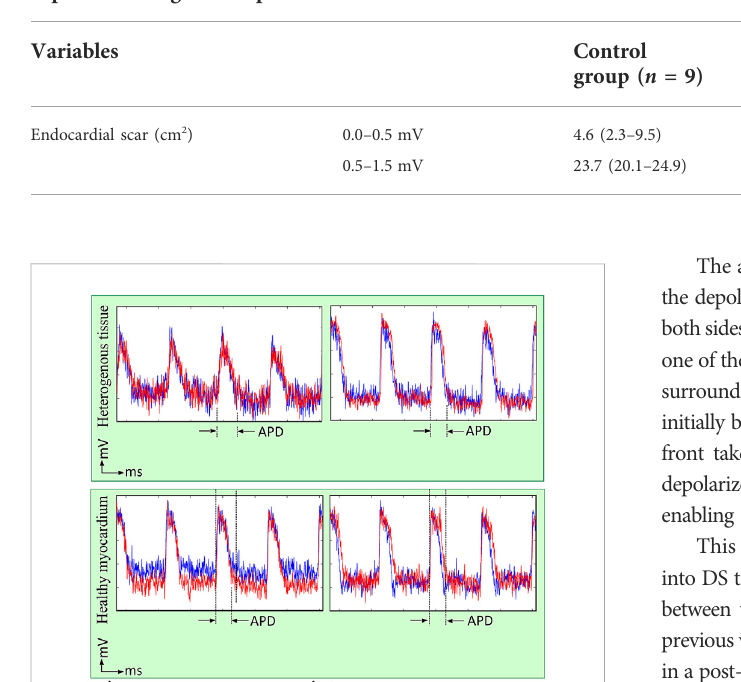
TABLE 3 Size of the endocardial scar evaluated with a high-density endocardial electroanatomic map. Shown are the median values of the variables and the p -value of the hypothesis contrast (Wilcoxon test).